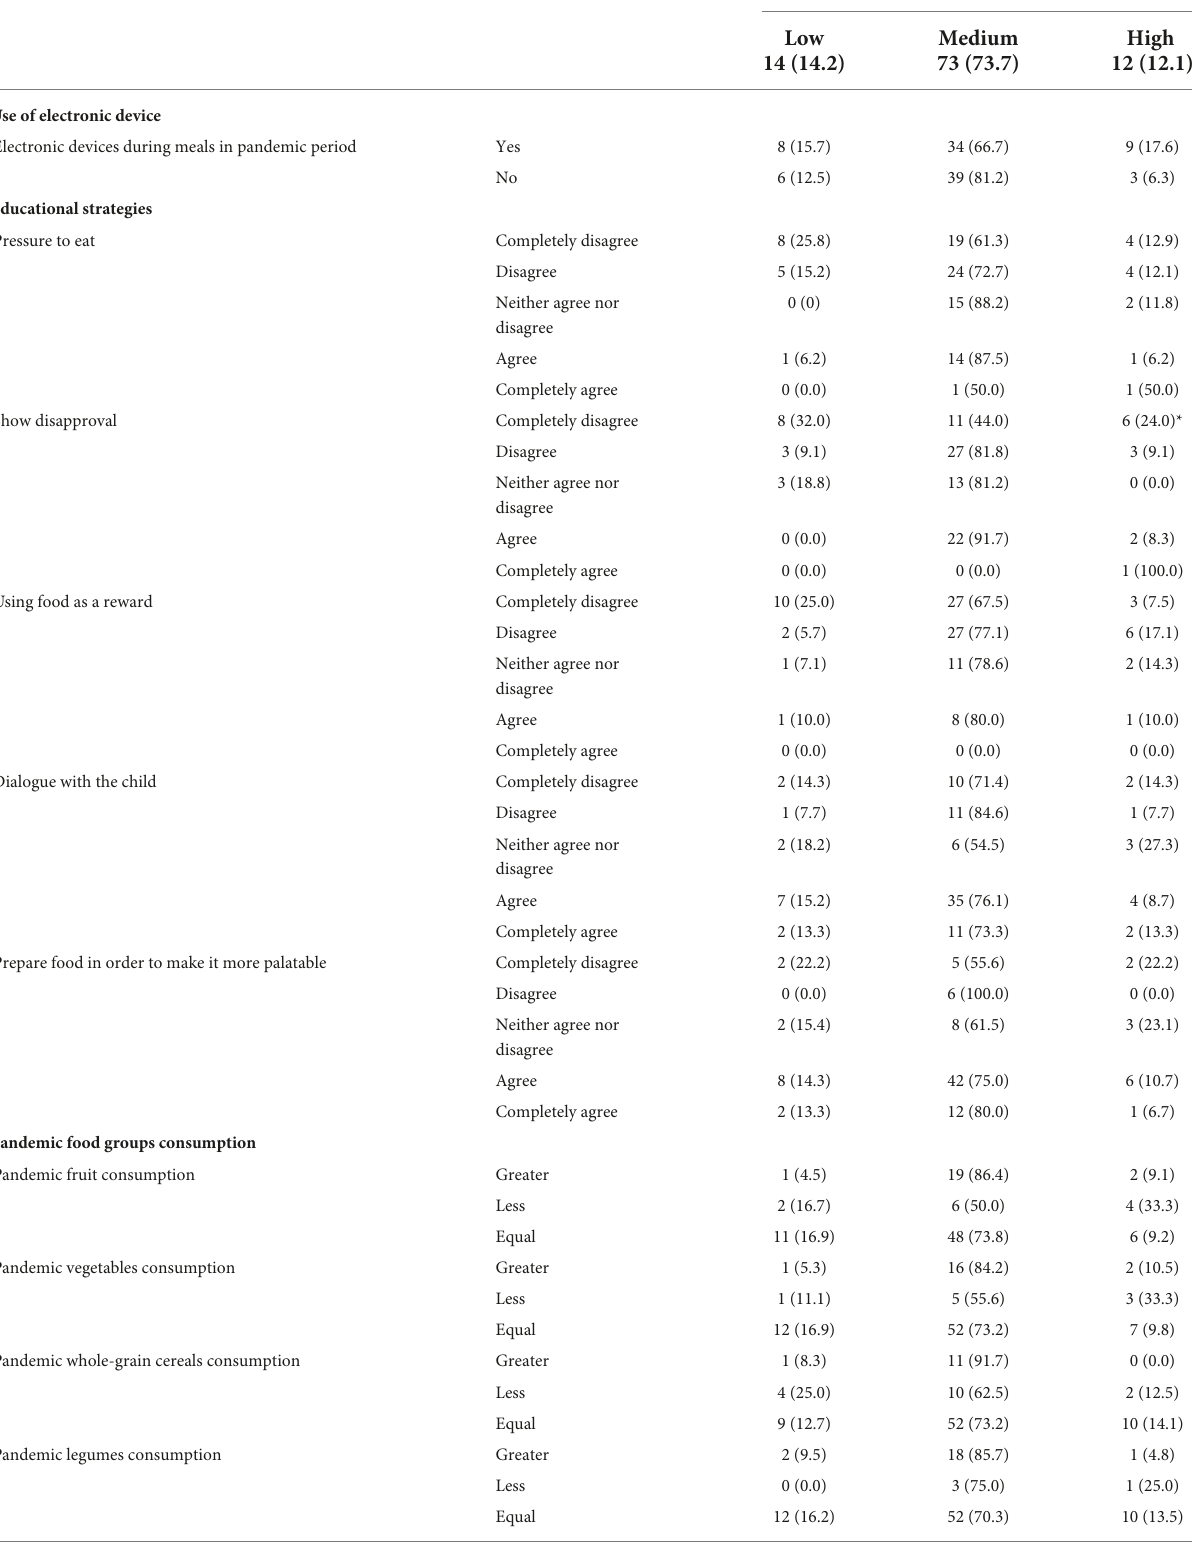
TABLE 6 The relationship between pandemic food groups’ consumption, use of the electronic device during meals, and educational